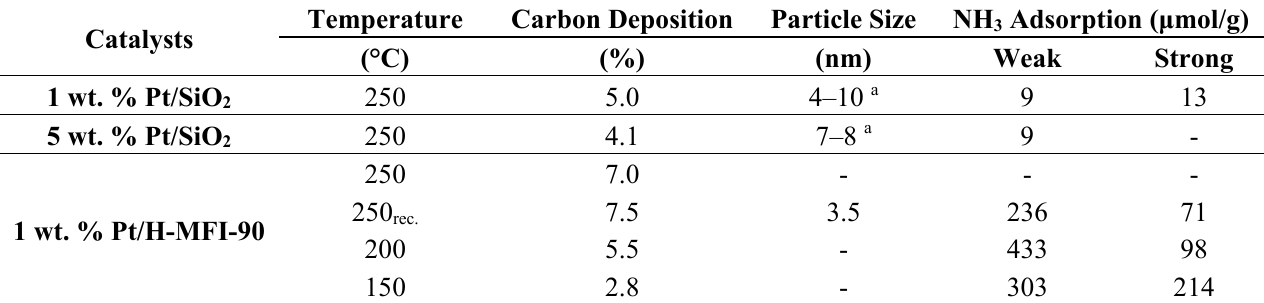
Figure 4. Results of the temperature programmed oxidation of ( a ) 1 wt.% Pt/H-MFI-90, ( b ) 1 wt. % Pt/H-MFI-90 rec. , ( c ) 5 wt. % Pt/SiO 2 and ( d ) 1 wt. % Pt/SiO 2 after the catalytic measurement at 250 °C (conditions: 1 L/min 10% O 2 in N 2 , T = 25 –700 °C, 5 K/min, ( a ) 100 mg; ( b – d ) 10 mg catalyst). Table 2. Catalyst properties after the catalytic measurements at 150, 200 and 250